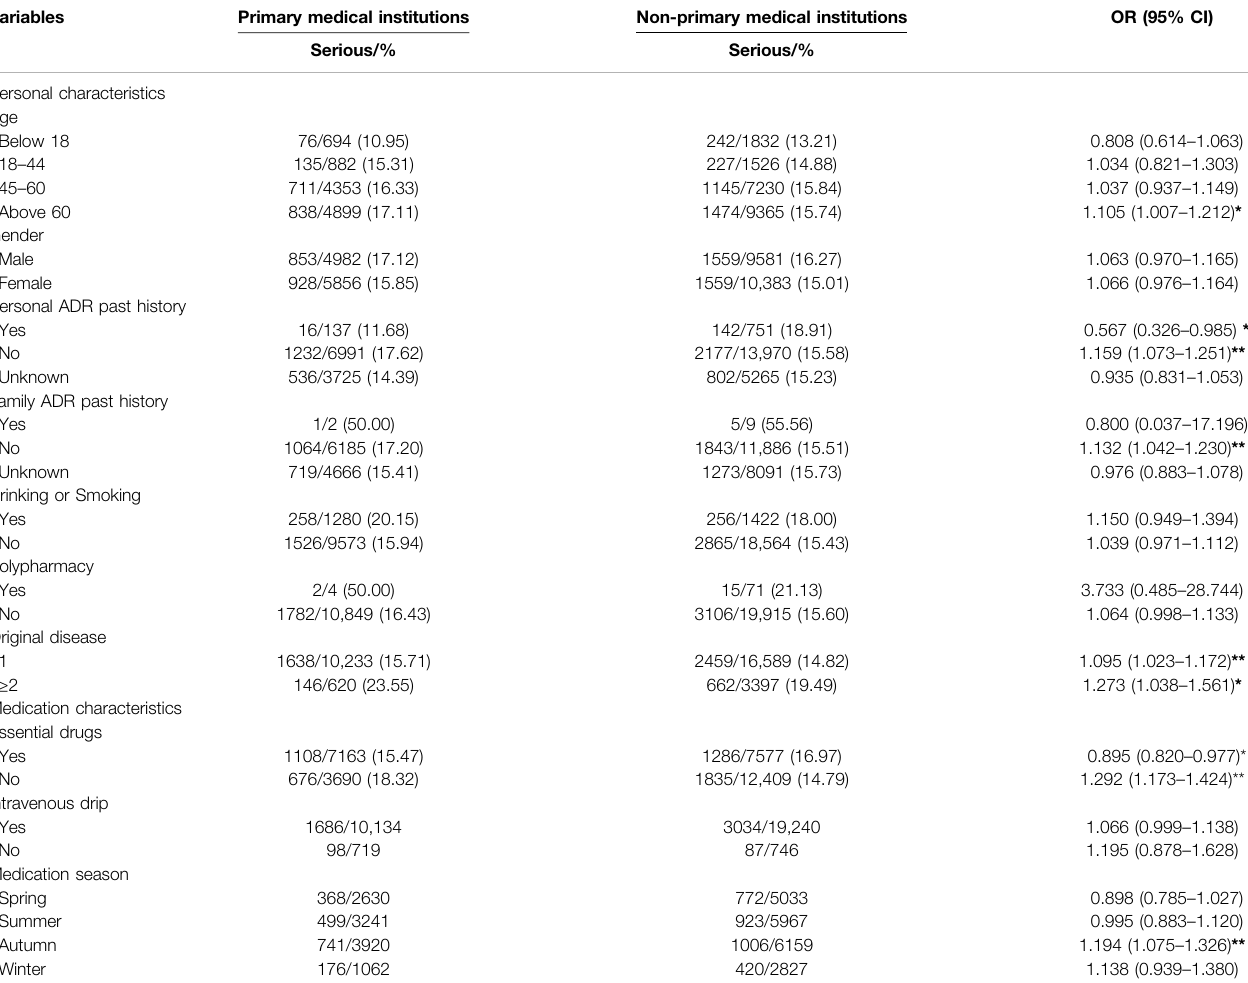
TABLE 6 | Hierarchical analysis of the personal and medication